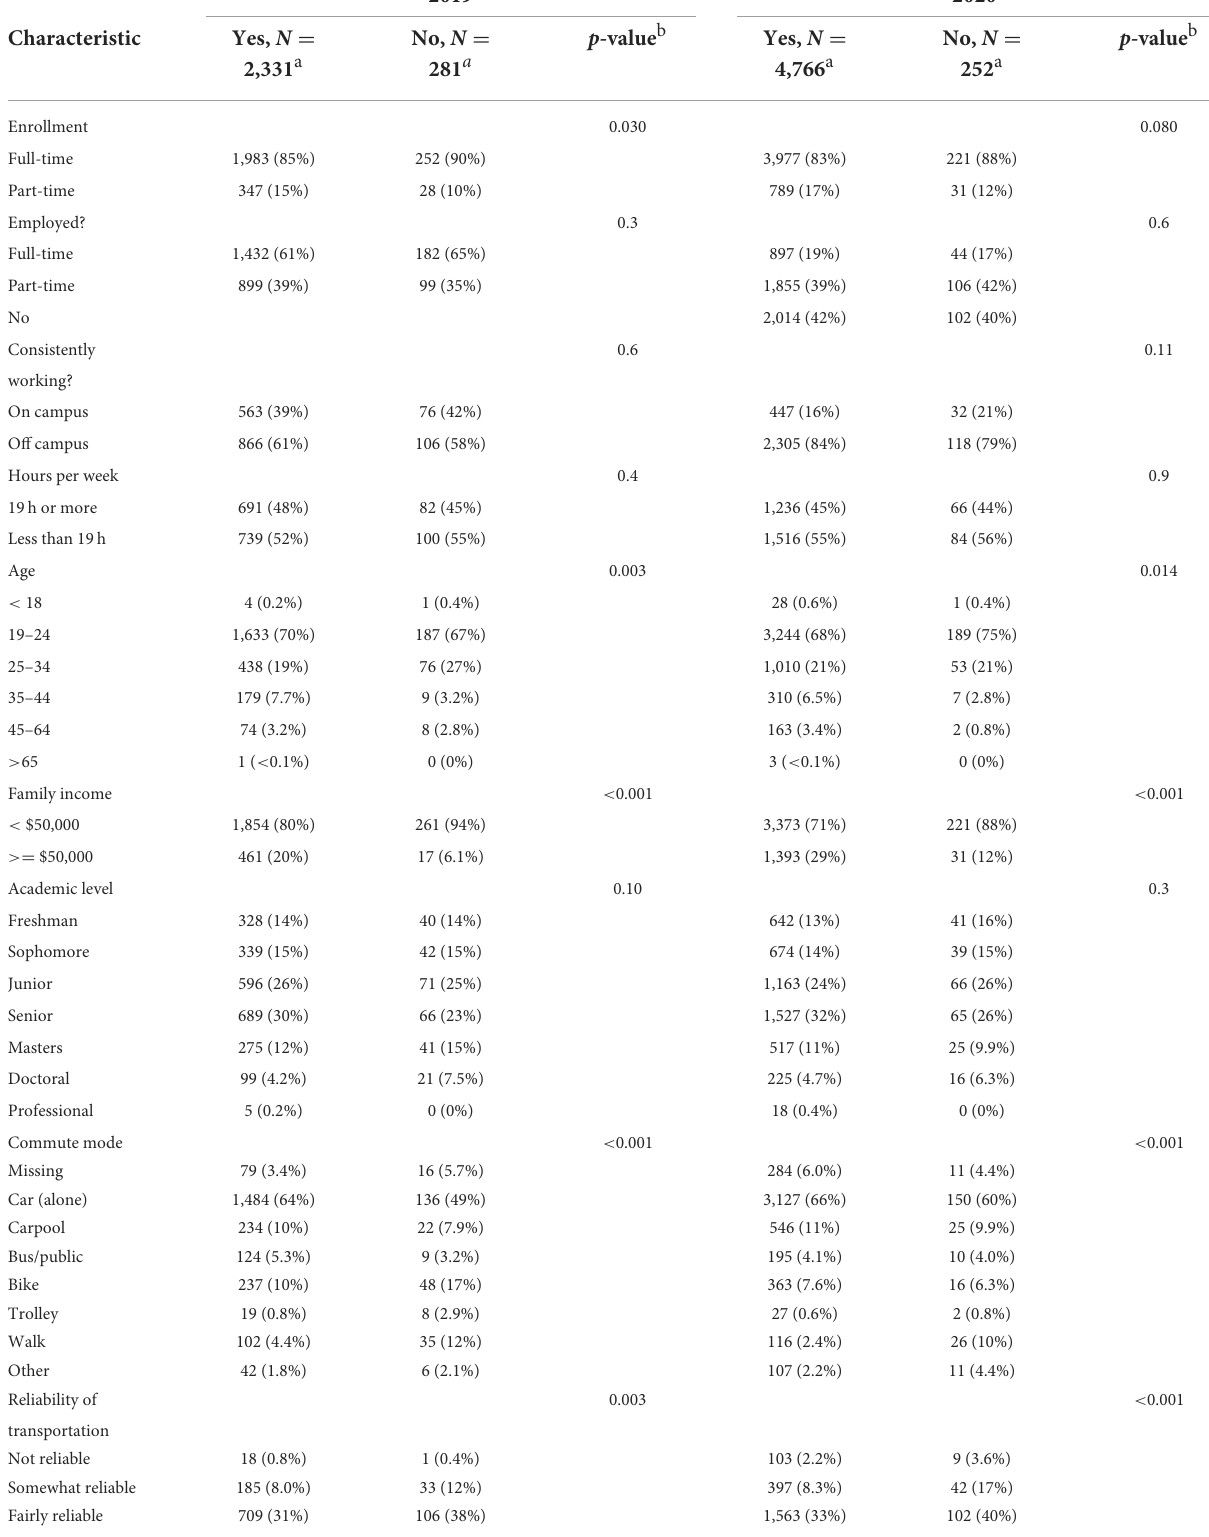
TABLE 3 Factors by year and housing security